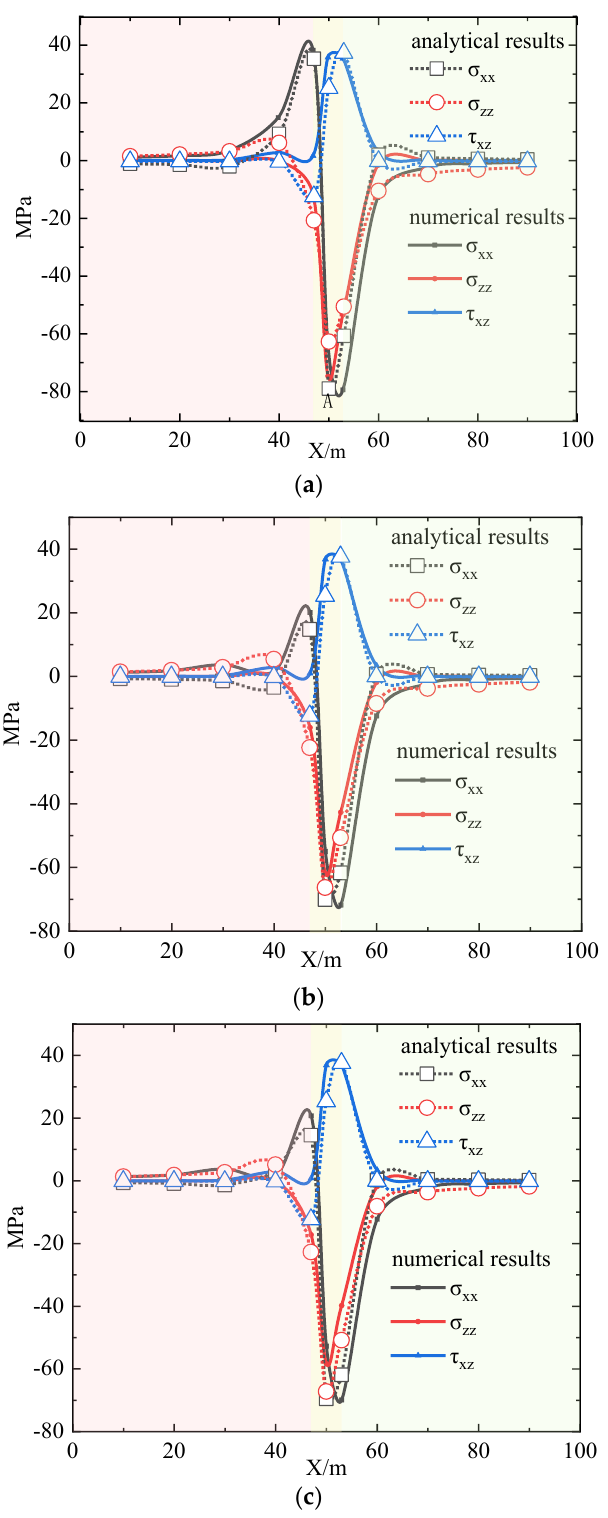
Figure 9. Comparisons between the proposed solution and numerical results for the values of μ 1 /μ 2 .